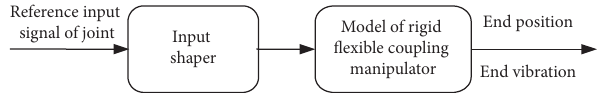
Figure 8: The control structure diagram of feedforward.